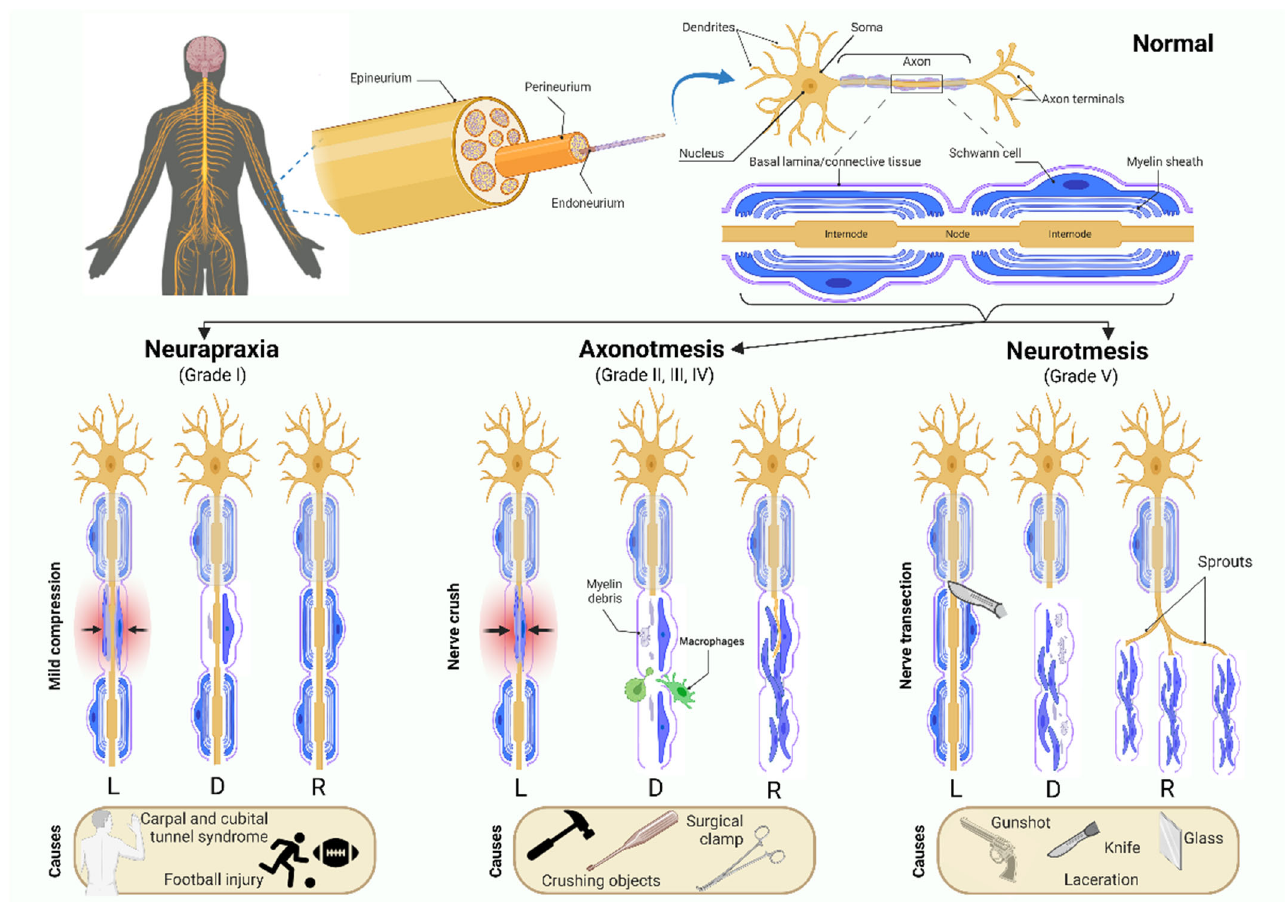
Figure 1. Different types of peripheral nerve lesions. Seddon (1943) classified them into neurapraxia, axonotmesis and neurotmesis, and Sunderland (1951) expanded on this classification to distinguish the extent of damage in the connective tissue: Grade I and Grade V correspond with Seddon’s neuropraxia and neurotmesis, respectively, while Grades II–IV are all forms of axonotmesis with increasing amounts of connective tissue damage. L—lesion; D—demyelination after neurapraxia or Wallerian degeneration after axonotmesis and neurotmesis; R—regeneration.